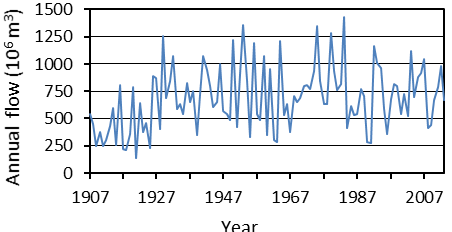
Figure 3. Annual flow of the Gash River measured at the Kas- sala Bridge gauging station (1907–2013; source: Gash Agricultural Scheme administrative office and Gash River training unit, Kas- sala).